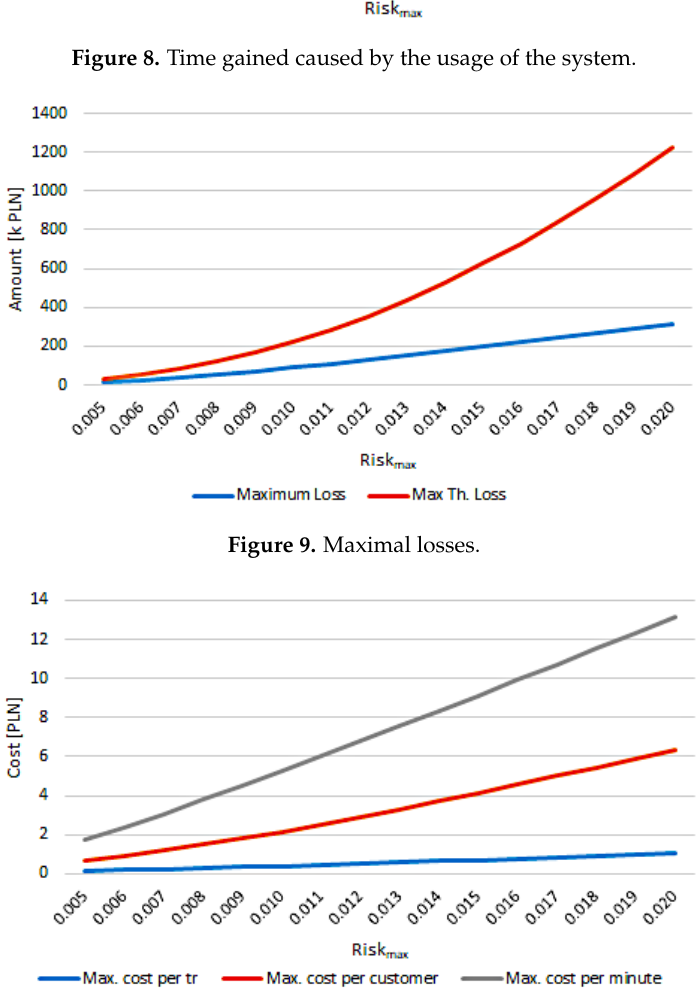
Figure 10. Max cost per one promoted cardholder, selected transaction and gained